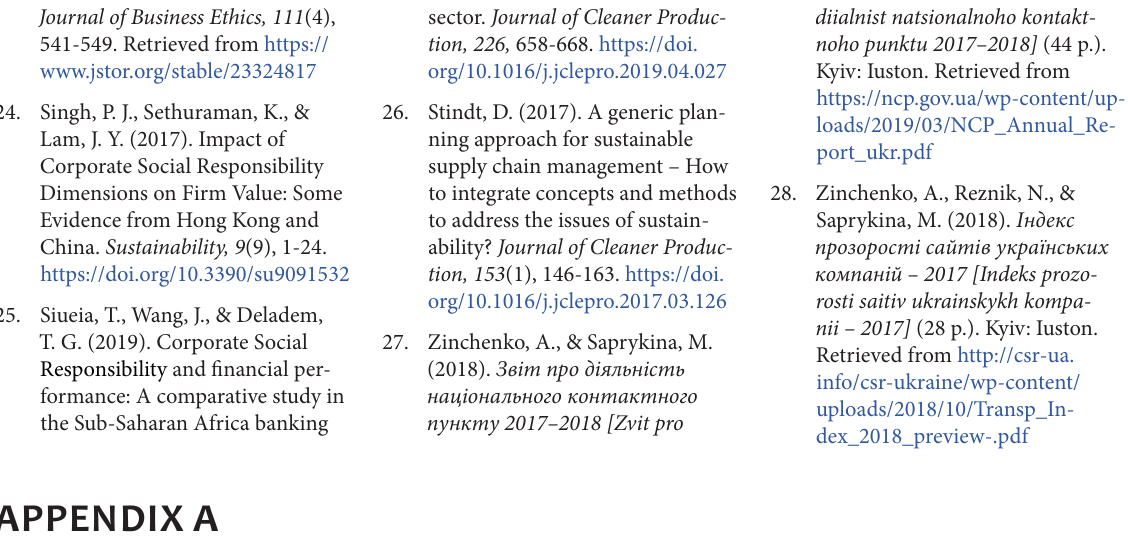
Table A1. The results of the multivariate analysis on corporate social responsibility development level